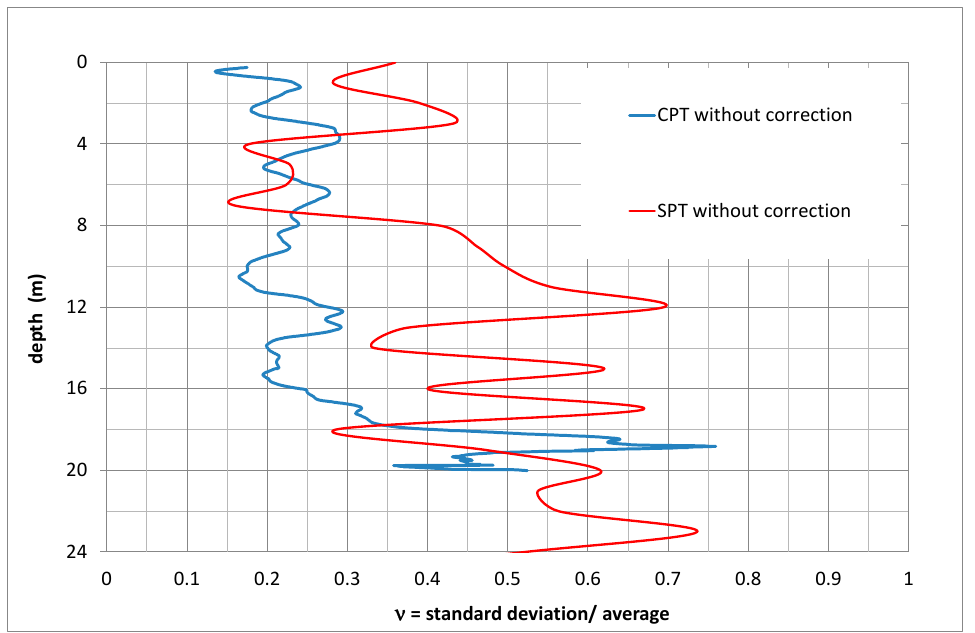
Figure 1. Dispersion on Standard Penetration Test (SPT) and Cone Penetration Test (CPT) before any statistical correction.